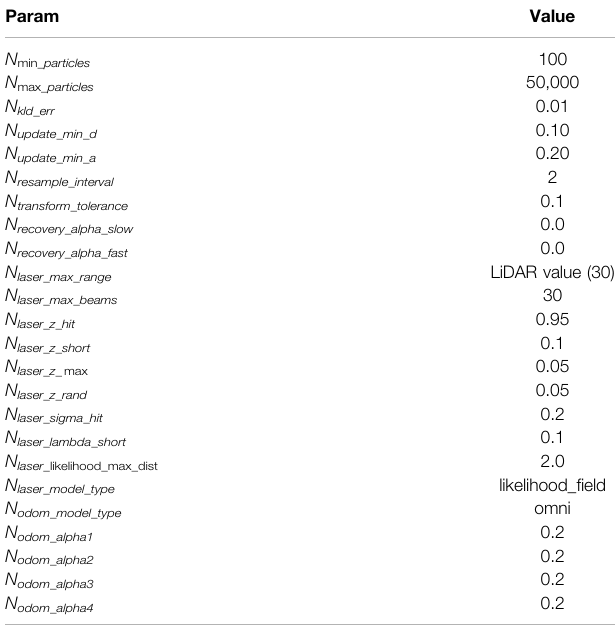
TABLE 2 | The con fi guration parameters used for running AMCL. Param